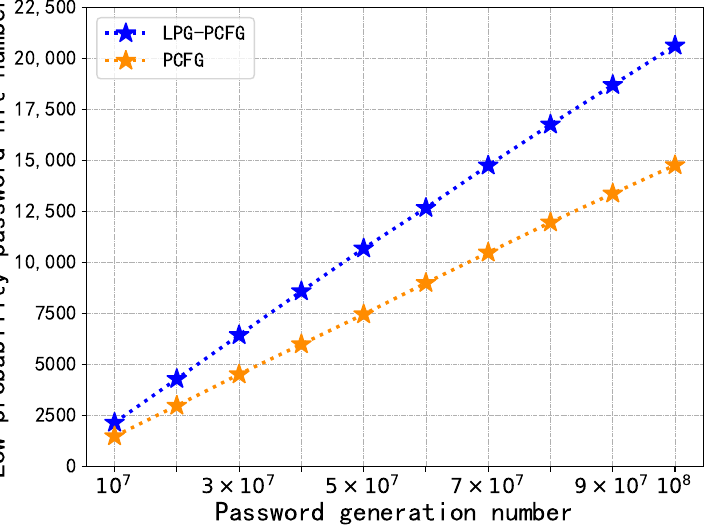
Figure 7. Performance comparison between LPG–PCFG and PCFG models (generated 10 8